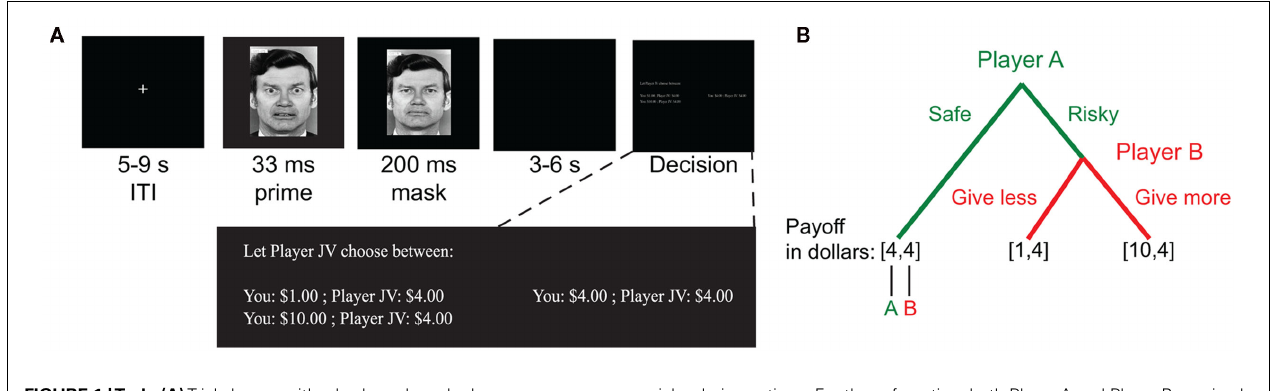
FIGURE 1 |Task. (A) Trials began with a backward-masked emotion face prime (fearful or happy face).This was followed by a decision period in which participants were assigned the role of Player A in a two-person two-stage response game. No time limit was imposed, and options were displayed until the participant made a choice. (B) Participants selected between safe and